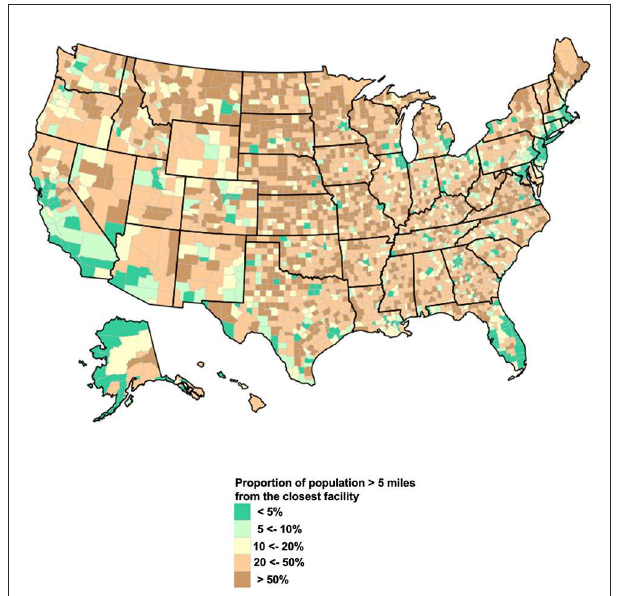
FIGURE1 Proportion of population with a driving distance to the closest facility ≥ 5 miles, by county. The map represents the proportion of population in each county with a driving distance > 5 miles to the closest health care facility.